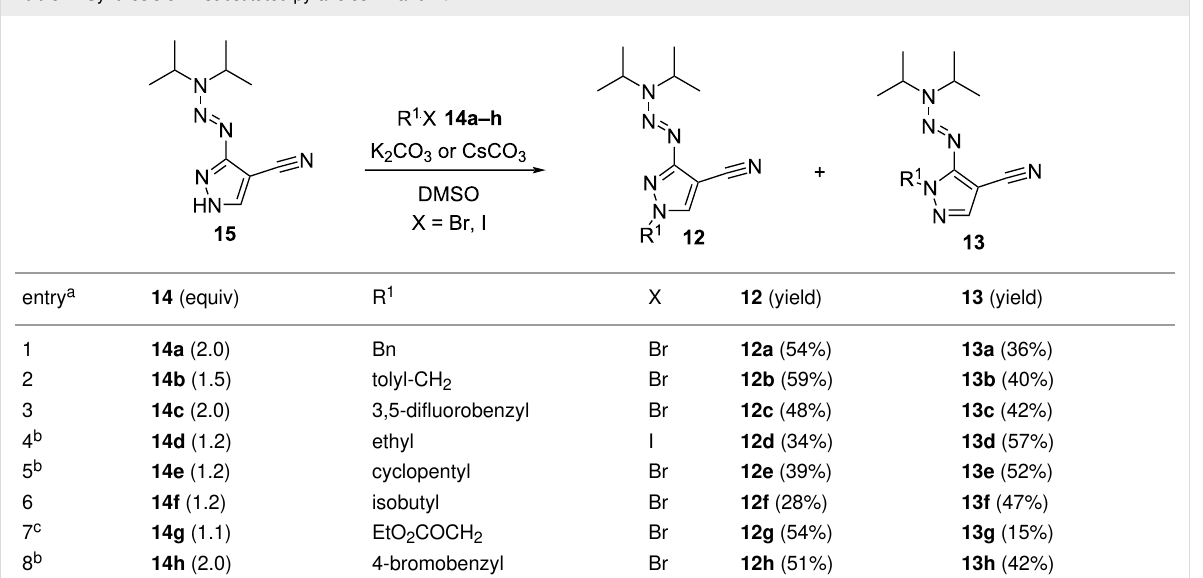
Table 1: Synthesis of N-substituted pyrazoles 12 and 13